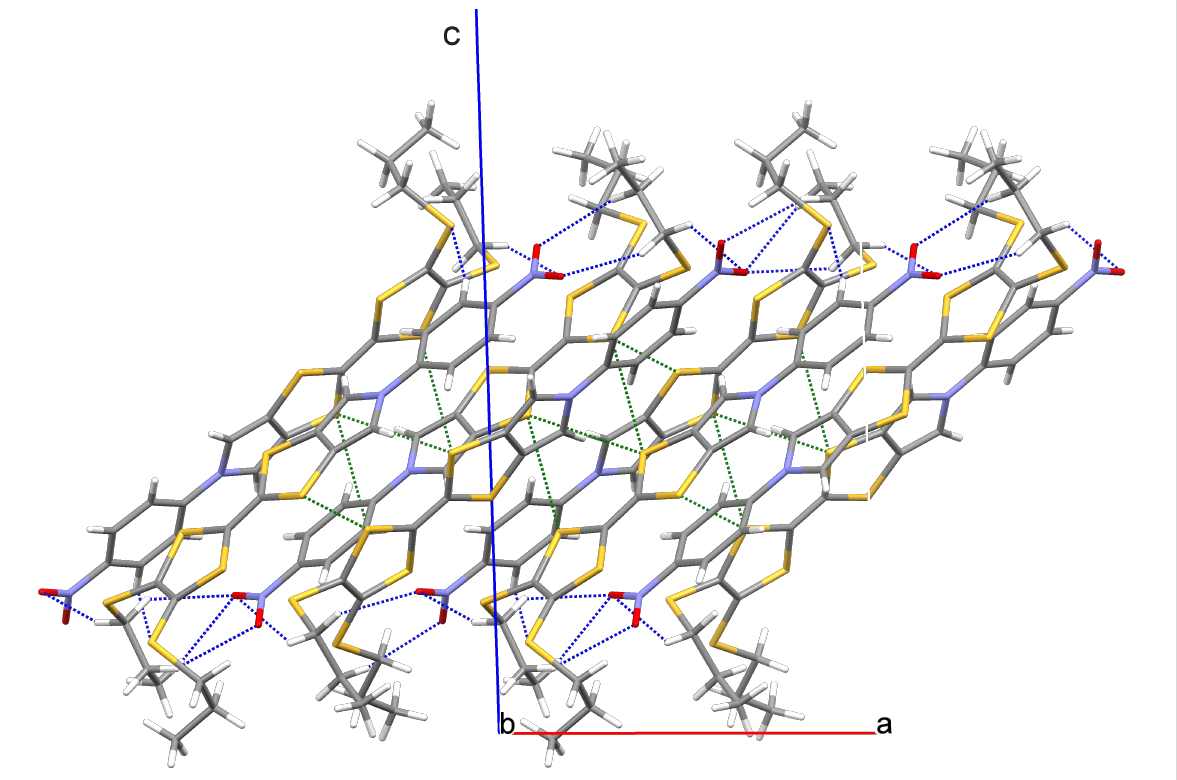
Figure 7: Crystal packing of 4d viewed along the b axis. Molecules of 4d form layers parallel to the (001) plane being interconnected with each other by means of short S···S contacts (green) and C–H···O 2 N weak hydrogen bonds (blue).